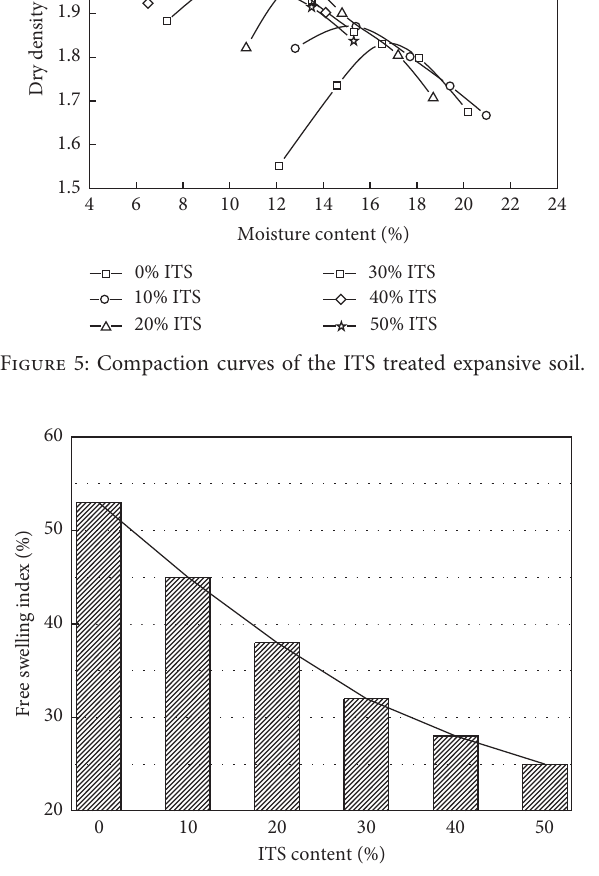
Figure 6: Relationship between the swelling index and ITS content.